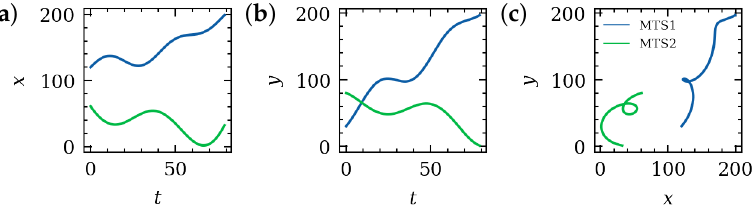
Figure 1. Transformation from multi-dimensional time series (MTS) to spatial objects. ( a ) Time series in dimension x ; ( b ) Time series in dimension y ; ( c ) The corresponding spatial objects embedded in the two-dimensional space R ( x , y ) .